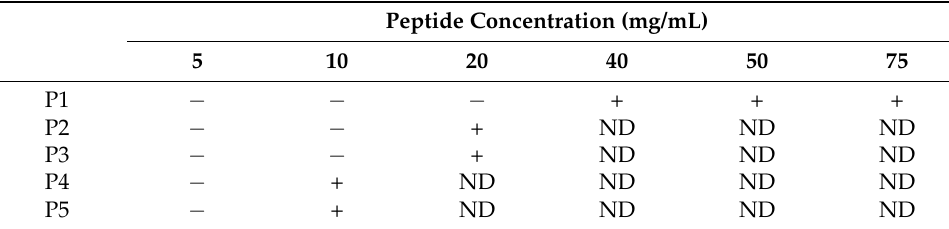
Table 3. Gelling ability of pellets solubilized at different concentrations and adjusted to pH 11. Peptide Concentration